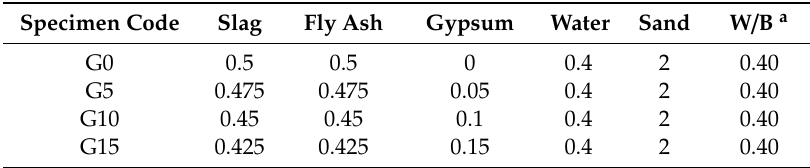
Table 2. Mix composition of the